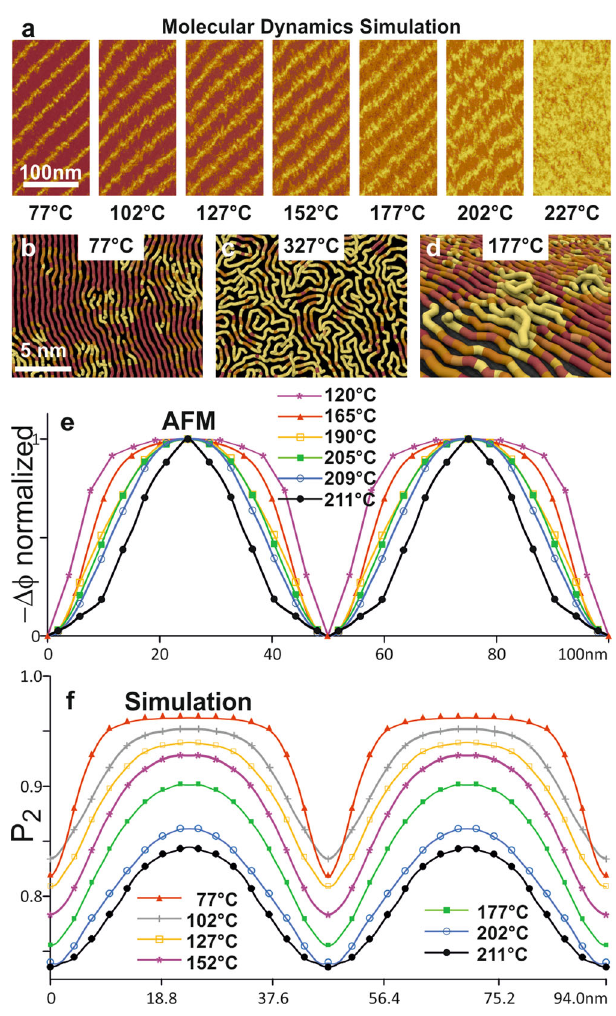
Fig. 4 Crystallinity maps and AFM phase shift pro fi les. a Crystallinity ( P 2 ) maps from MD simulations for temperatures between 77 and 227 °C (for details see section 2.1, Supplementary Information). Each map was calculated by partitioning the simulated surface into a 1 nm × 1 nm grid, and then locally averaging P 2 values across 51 instantaneous con fi gurations (at 100 ps intervals). b , c Magni fi ed snapshots of the simulations at 77 and 327 °C produced using OVITO 47 . The tubes correspond to individual alkane chains, and are colored according to their P 2 values. d A 3D MD simulation snapshot, taken at 177 °C, showing how chain segments detach from the substrate and cross over each other to resolve the overcrowding problem at the crystal-melt boundary in thin fi lm. e Averaged and normalized AFM phase shift ( − Δ ϕ ) pro fi les of C 390 H 782 at temperatures from 120 to 211 °C, with maximum phase shift at the surface (as 0) and minimum (as 1) at the center of the lamellae. f P 2 pro fi les calculated from the respective simulated P 2 maps. In our MD simulations the abscissa values are measured along the molecular direction which was actually inclined to the observed